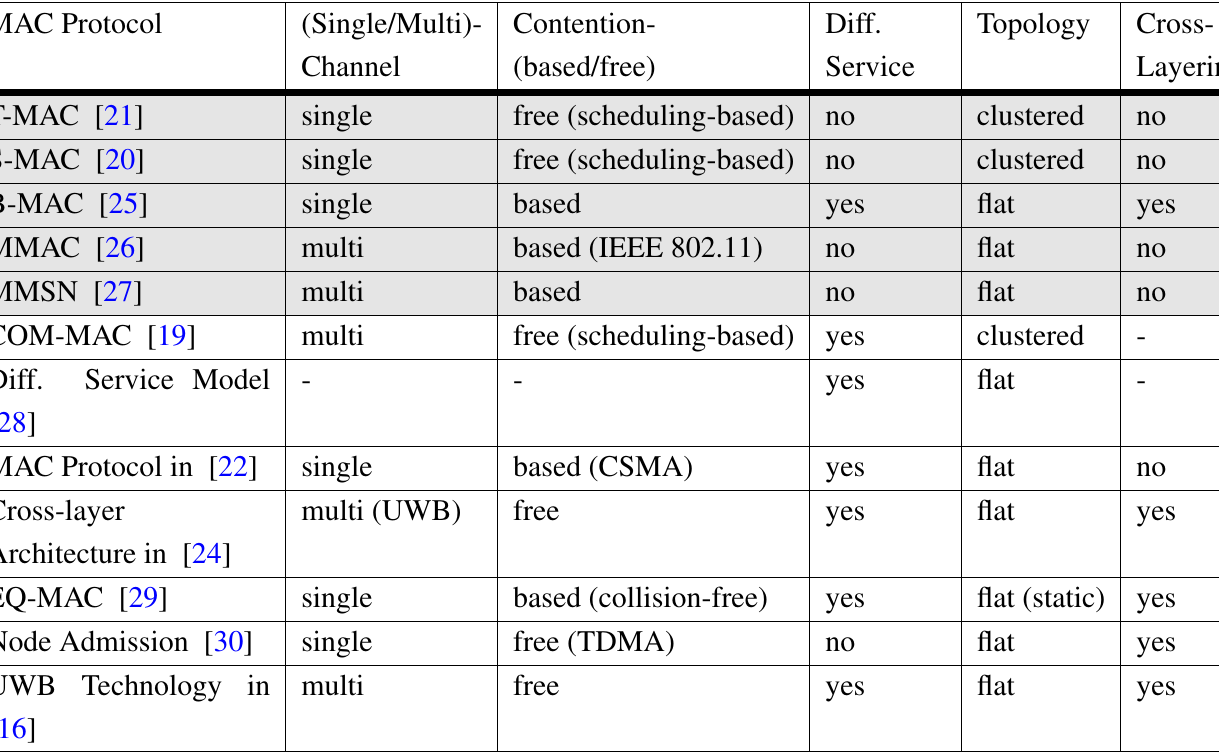
Table 2. A Comparison between MAC Layer Protocols. Grey rows indicate that the MAC protocol is designed for WSNs but not specifically for